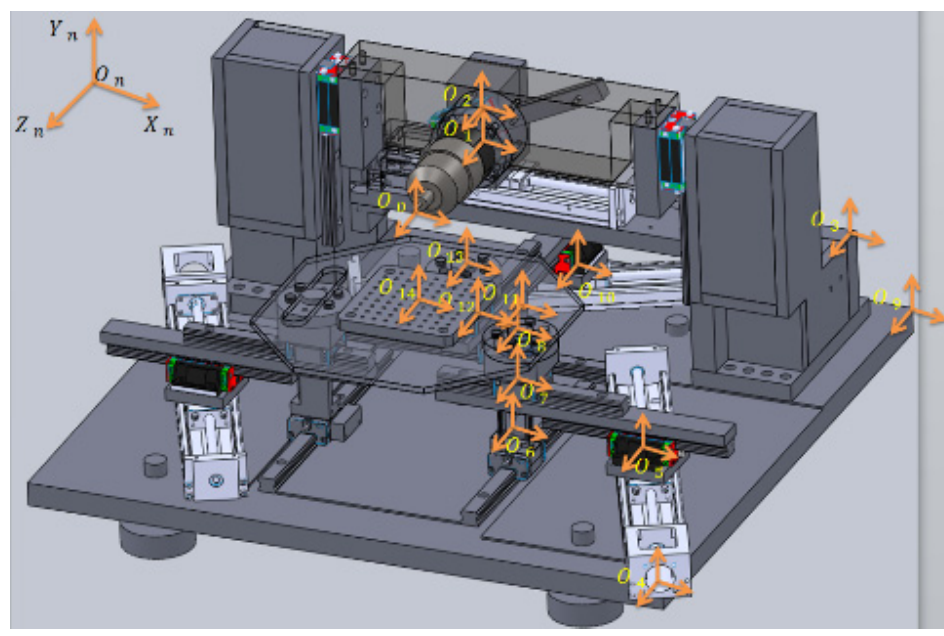
Figure 7. Coordinate frames defined for the machine. Table 1. Parameters of translation and rotation error.